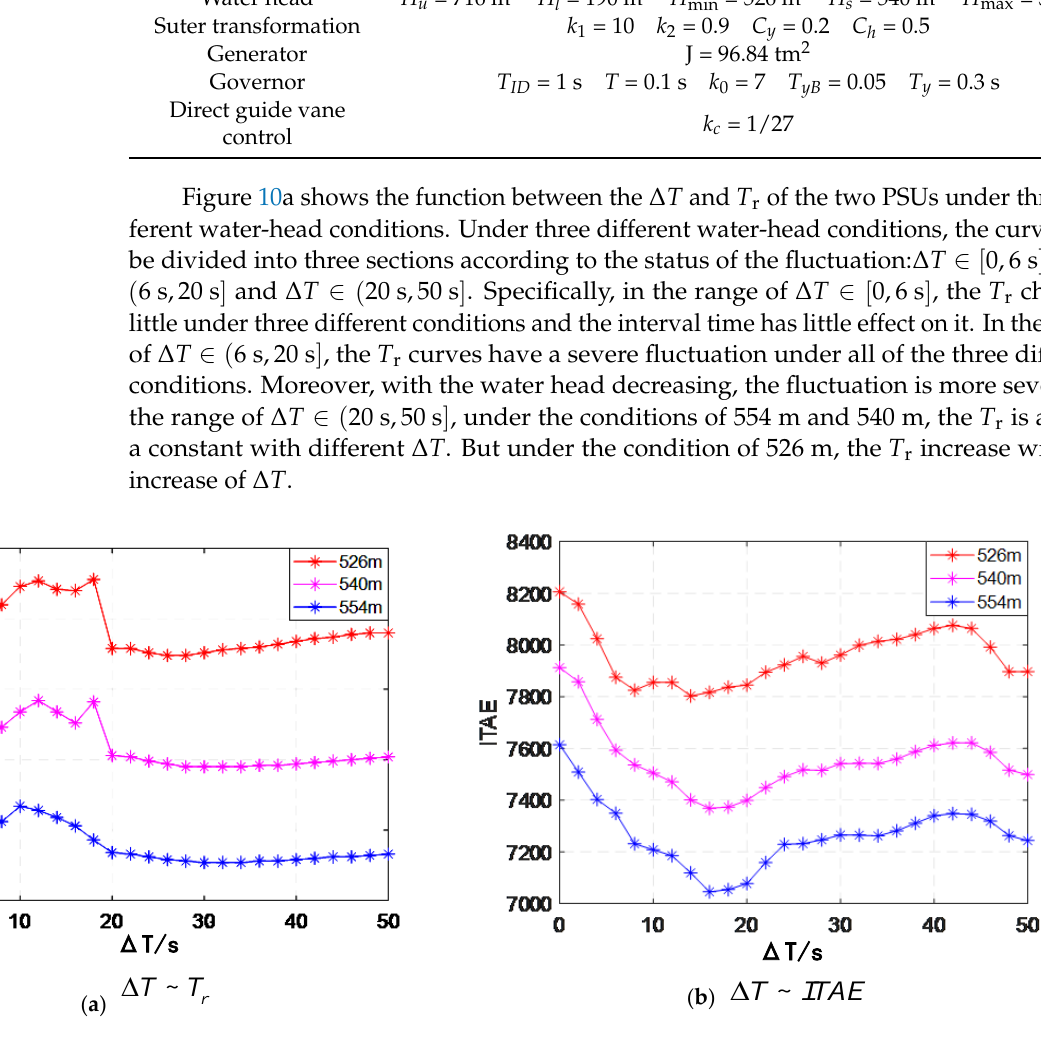
Figure 10. Influence of interval time T on T r and ITAE of rotational speed.